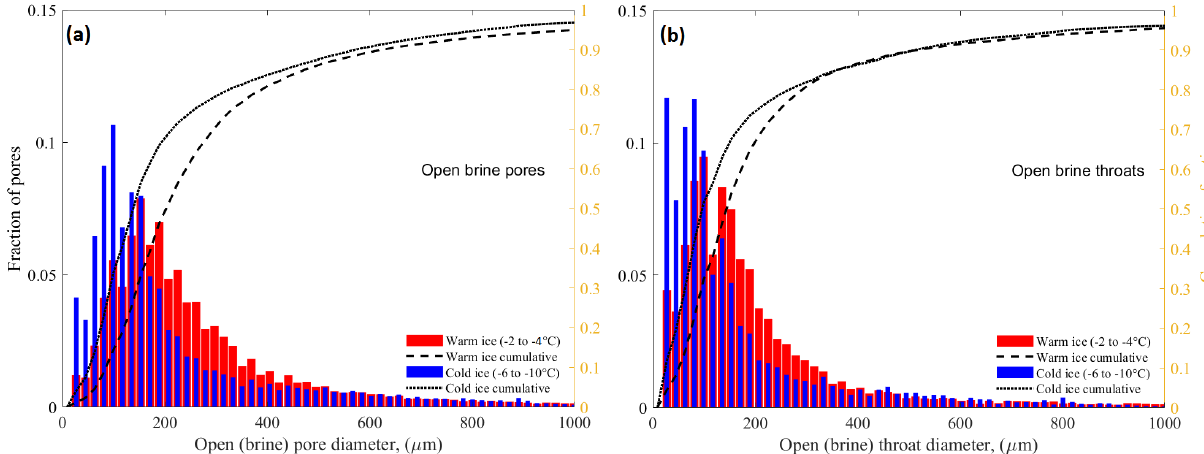
Figure 10. Pore size distributions based on XRT imaging of four young ice cores. (a) Fraction of open brine pores in 18µm wide size bins for the two warmest (red) and two coldest (blue) cores. The corresponding cumulative fractions are also shown with the y axis on the right-hand side; (b) same as (a) but for the porosimetry and fraction of pores